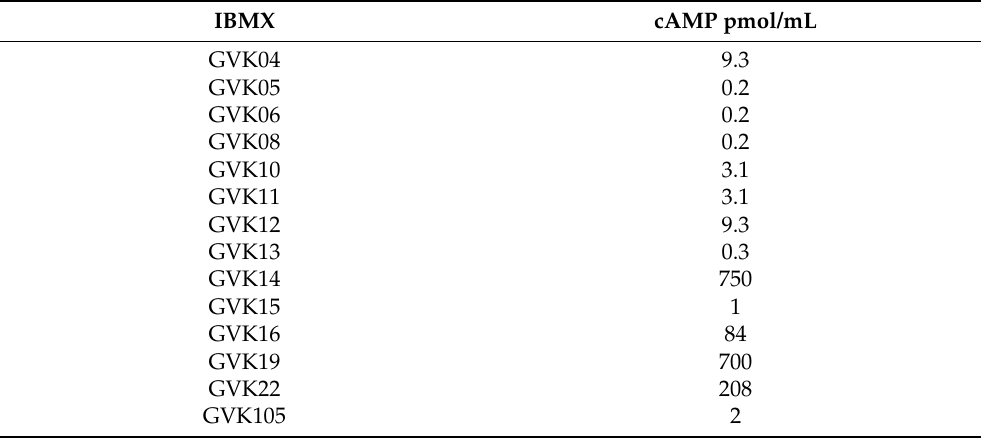
Table 3. Values of cAMP levels (pmol/mL) secreted in T. cruzi with respective xanthine